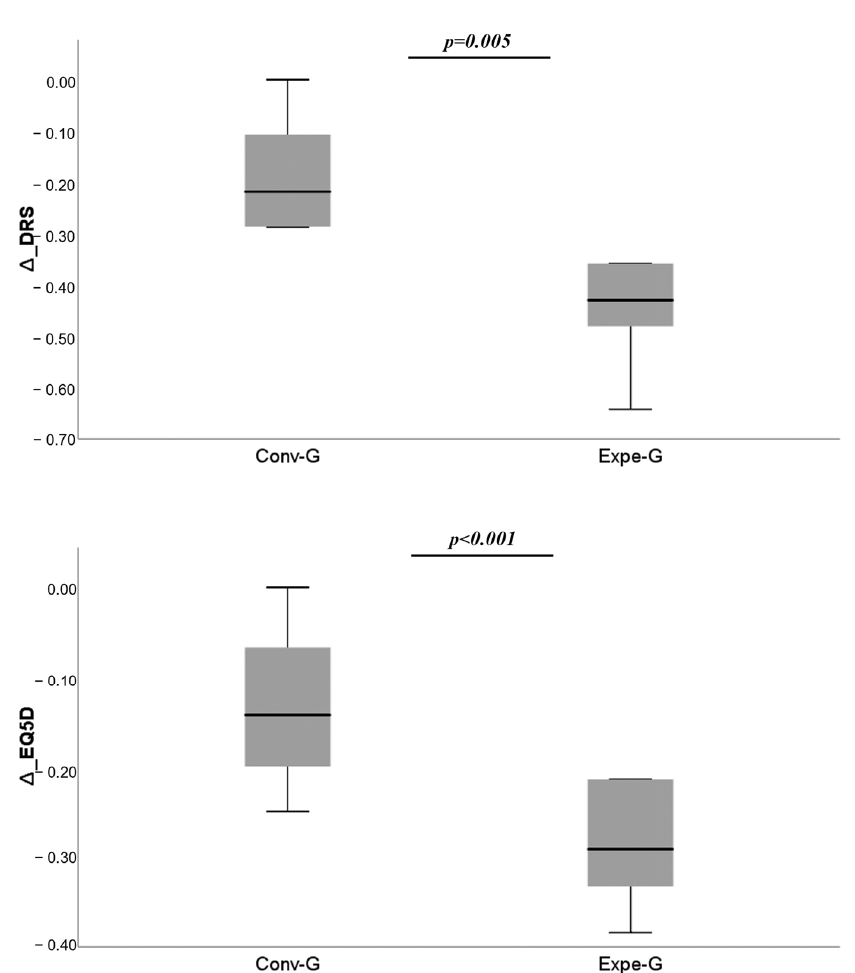
Figure 3. The comparisons of change ( ∆ ) for DRS (disability) and EQ-5D (quality of life) show significant differences between Expe-G and Conv ‐ G.